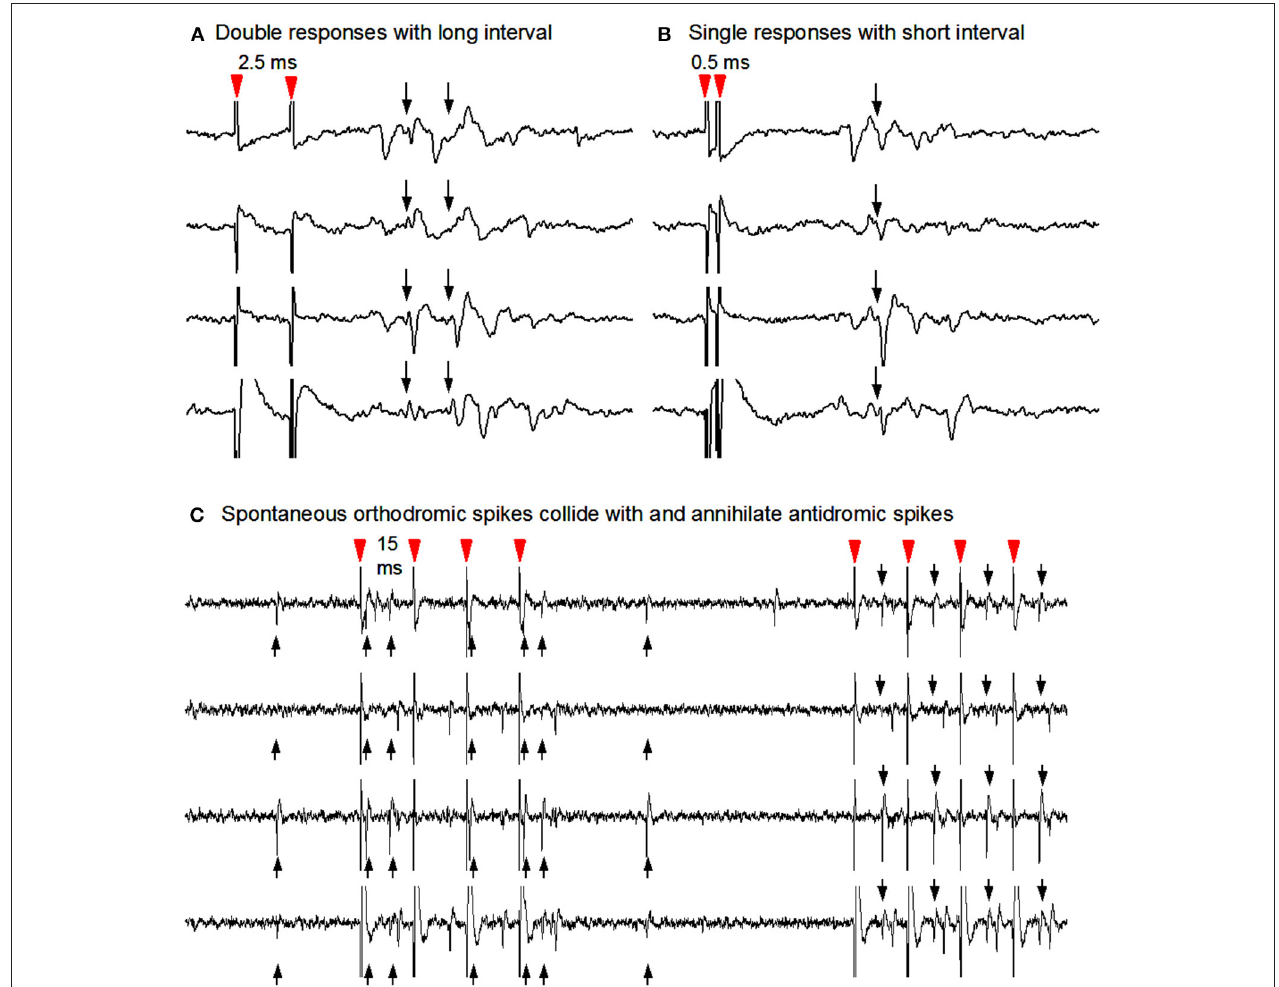
FIGURE 4 | Antidromic stimulation-collision method to identify striatonigral neurons. (A) Nigral stimuli 2.0ms apart elicited two corresponding spike responses at the recorded SPN soma. (B) Nigral stimuli using 0.5ms interstimulus interval in order to show single response due to the Na channel inactivation-induced refactory period. (C) Collisions from the same unit’s antidromic spikes (downward arrows) with its spontaneous orthodromic spikes (upward arrows) are evident in the first 4 stimuli and not in the latter four during which no spontaneous orthodromic spikes occurred. Note that antidromic spikes are time-locked to the stimuli (red arrow heads).